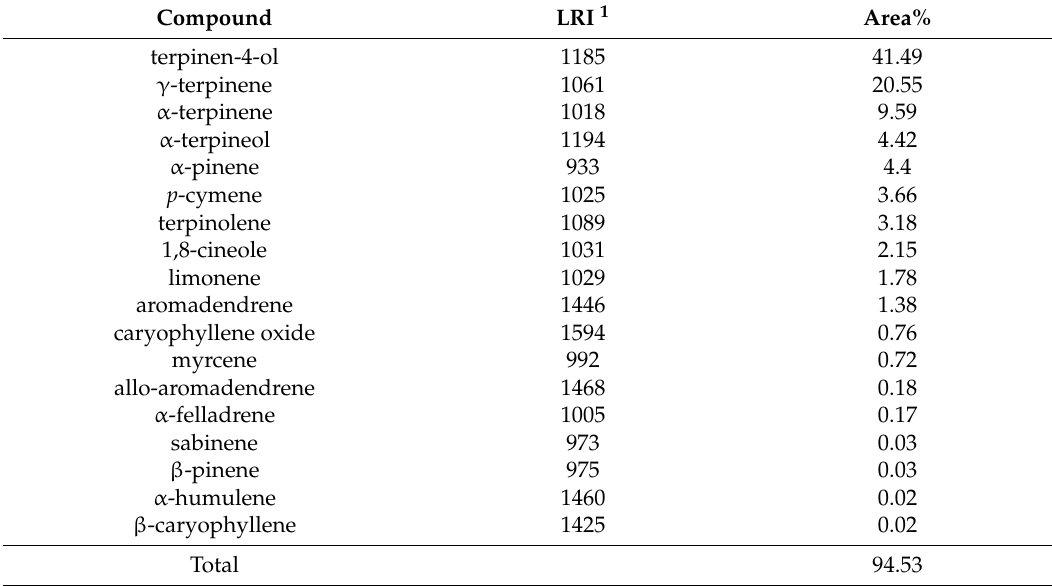
Table 1. Composition of tea tree oil